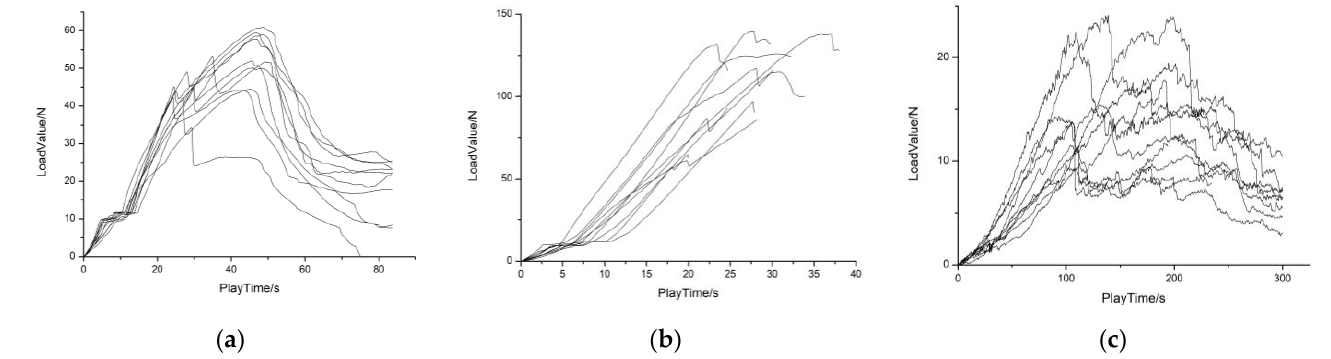
Figure 4. Mechanical properties curve of the rape shoot stalk: ( a ) stalk axial compression characteristic curve; ( b ) radial compression characteristic curve of stalk; ( c ) stalk shear characteristic curve.